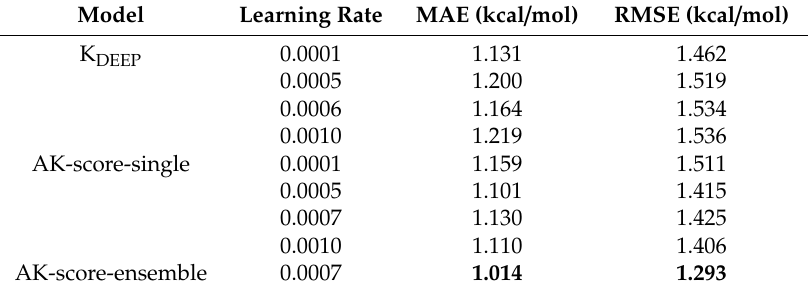
Table 1. Assessment of prediction accuracy of ResNext-ensemble, ResNext, and K DEEP using the PDBbind-2016 dataset and mean absolute error and root mean square error